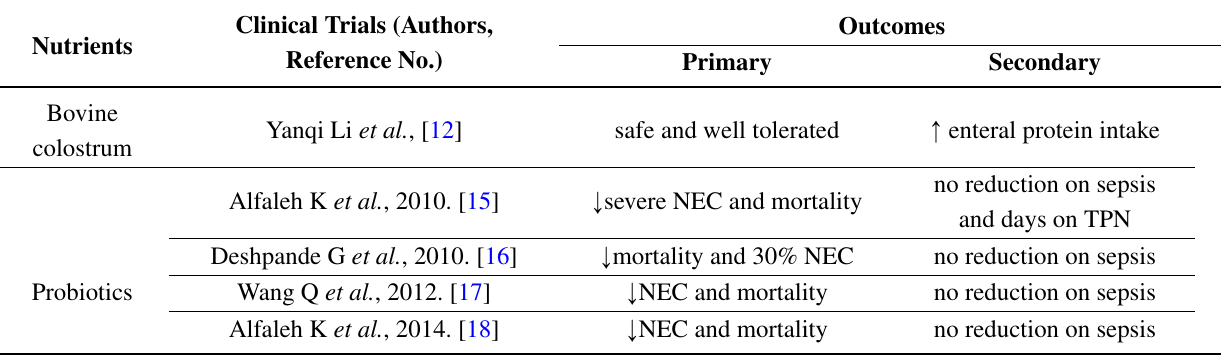
Table 2. Evidences of nutritional supplementation in the prevention of